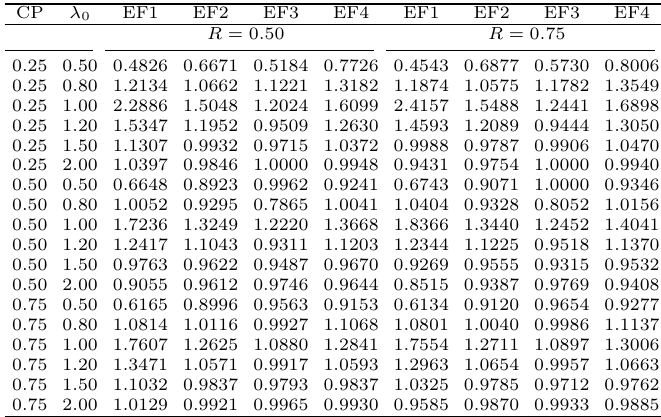
Relative efficiencies of the estimators for R ( t ) under Type II censoring